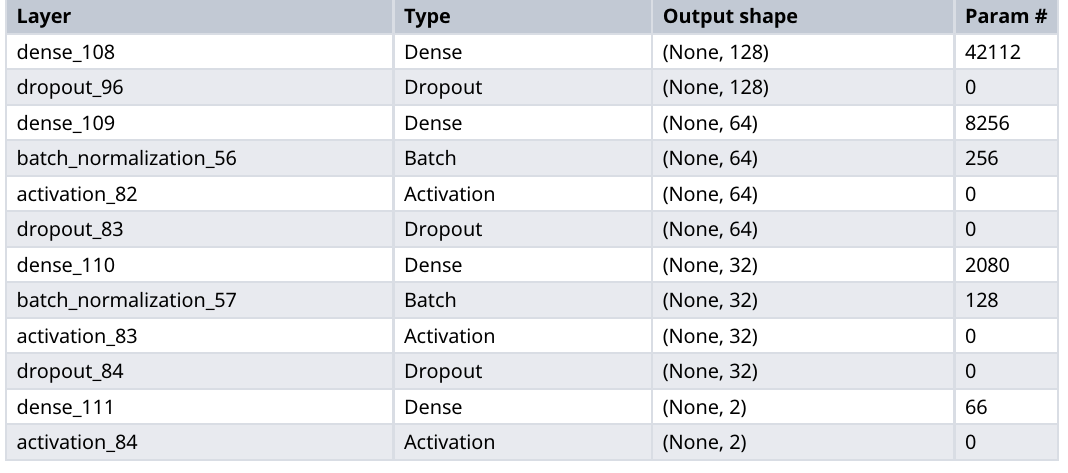
Table 1. Layers of the deep neural network implemented in this